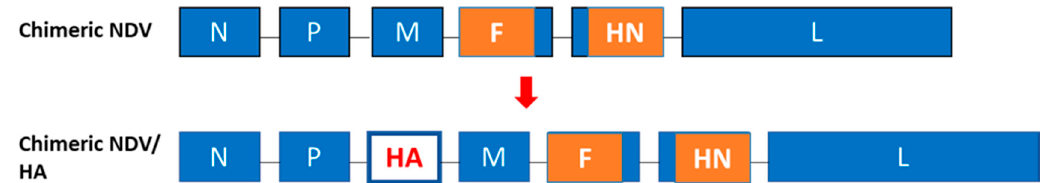
Figure 1. Generation of chimeric NDV-vectored vaccines. Ectodomains of the F and HN genes derived 257 from APMV-2 are shown as orange rectangles. The HA gene was placed between the P and M of the 258 chimeric NDV genome. 259